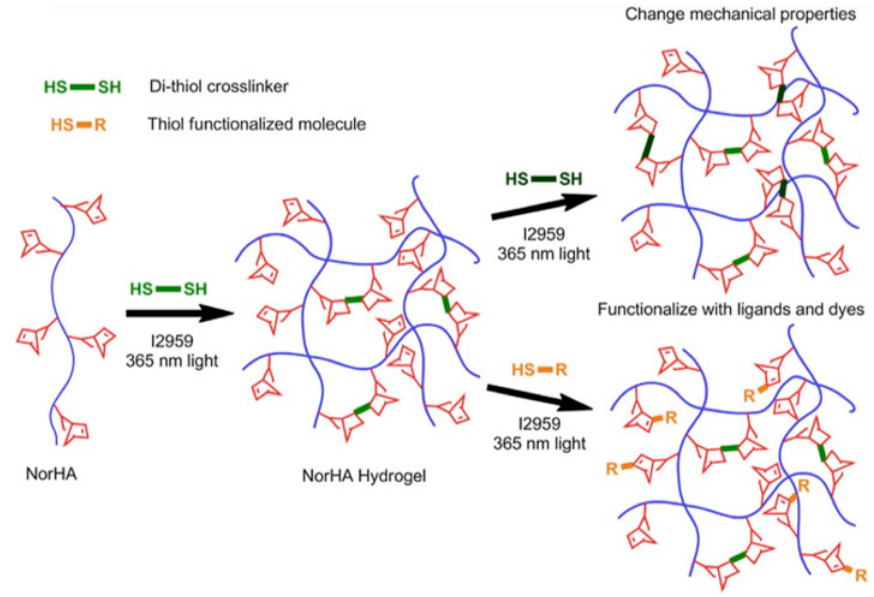
Figure 2. Synthesis scheme of hydrogel [37]. Reproduced with permission from Elsevier, 2013.